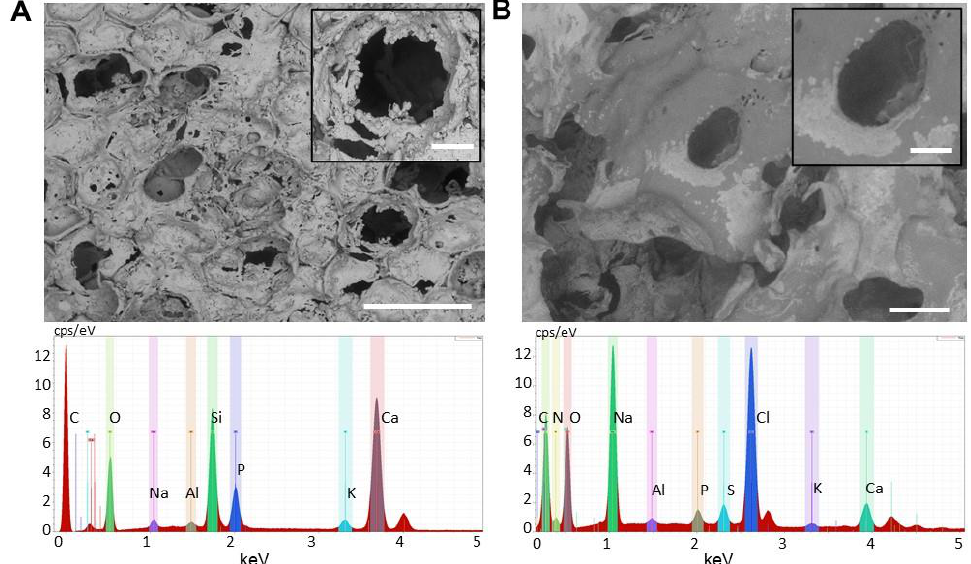
Figure 1. SEM micrographs (on the top, bar = 1 mm) and EDS analysis (on the bottom) of the 3D porous glass-ceramic scaffold before ( A ) and after Layer-by-layer surface modification ( B ). The insets of the SEM show the macrographs of the pores (Magnification 200 × , bar = 200 µ m). Before the LbL assembly, the conjugation of dopamine to the chondroitin sulphate did not affect the ζ -potential of the PE solution ( − 16.3 mV respect with − 18.9 mV of pure CS), while the gelatin solution was always positively charged with ζ -potential of +10.8